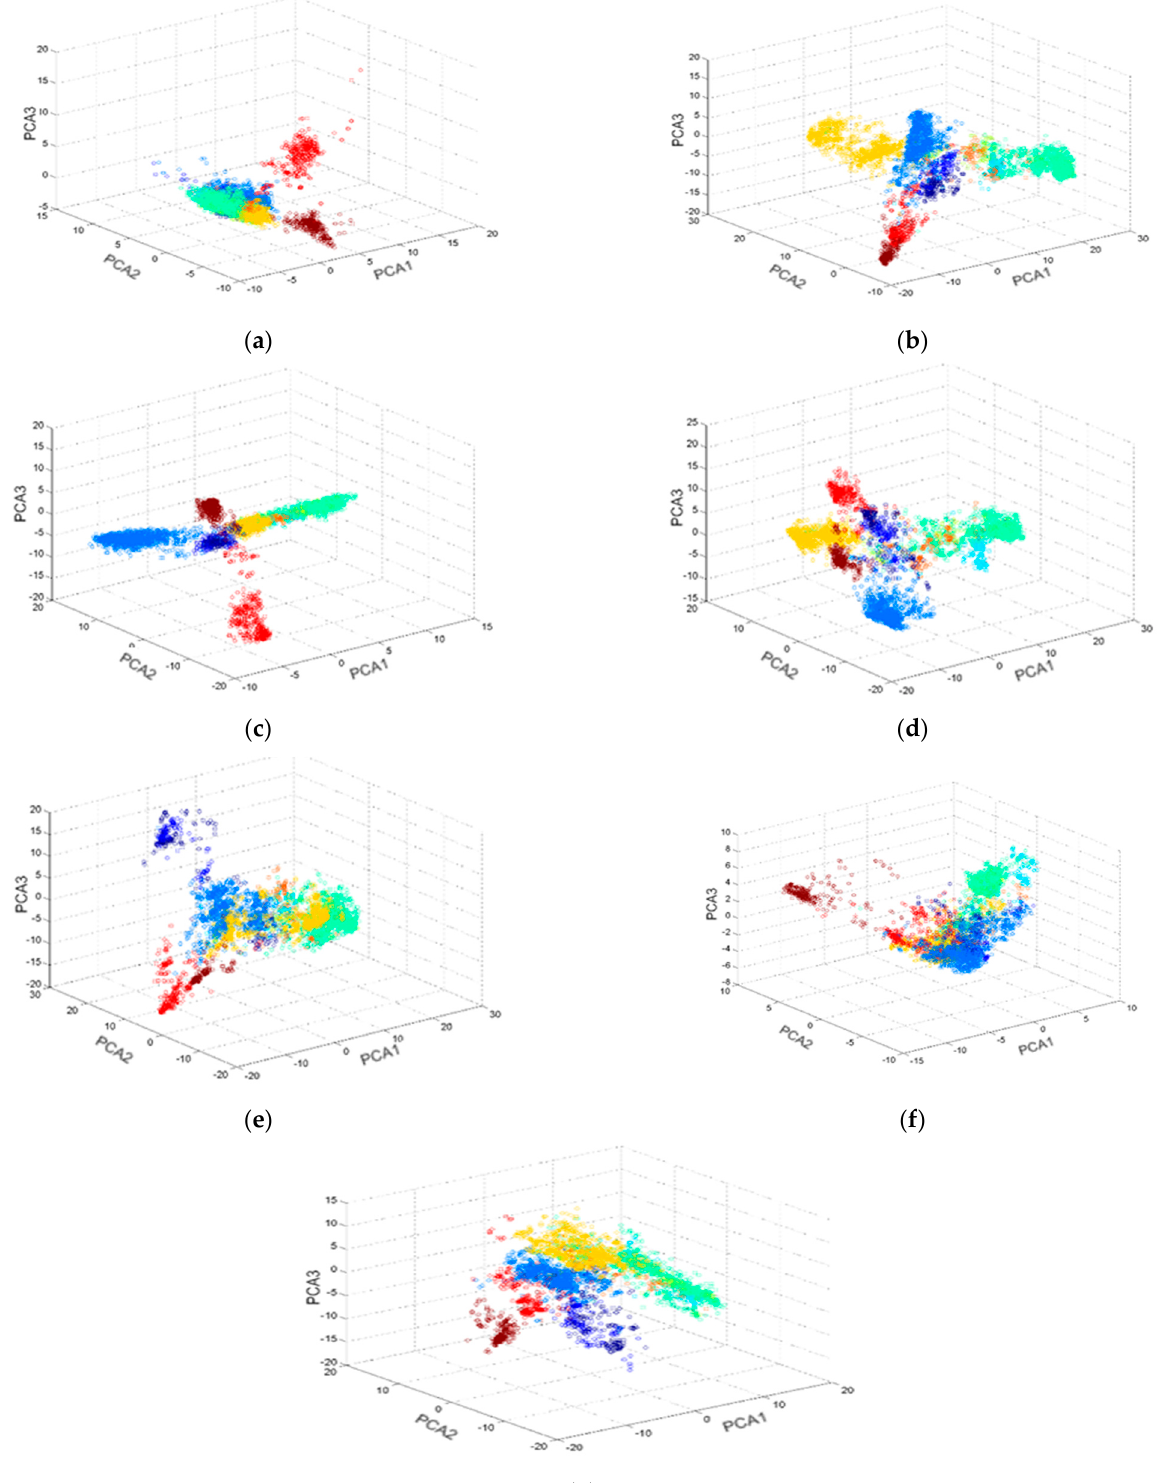
Figure 16. 3D − scatter plots based on seven fingerprints and representations of descriptors: ( a ) ALogP, ( b ) CDKFp, ( c ) ECFP4, ( d ) EPFP4, ( e ) GraphOnly, ( f ) MDL, and ( g ) PubchemFp of 5083 different molecules that were selected from the 10 biological activity classes of the MDDR dataset.